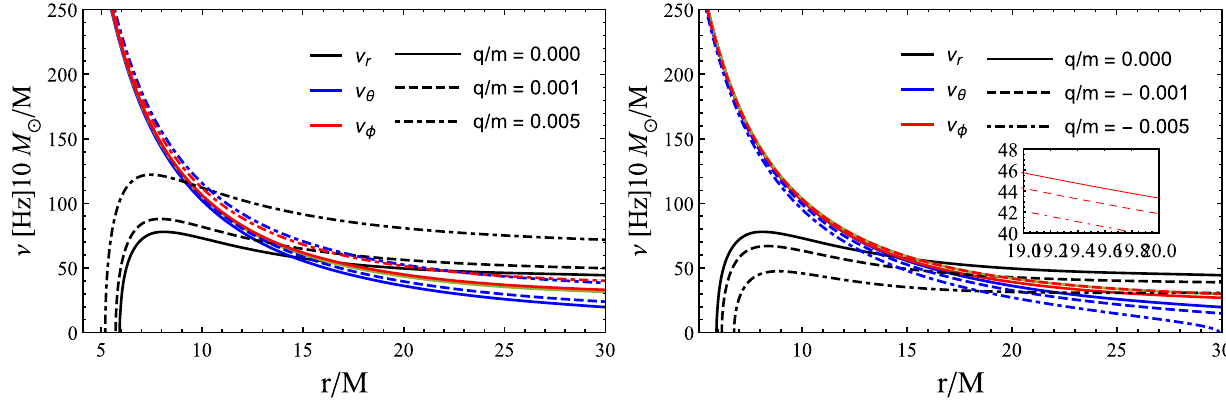
Fig. 7 Plots showing the epicyclic frequencies as a function of r / M in the case with a charged particle. Radial, latitudinal and orbital frequencies are plotted for various combinations of charge parameter ± q / m while keeping the magnetic parameter B = 0 . 005